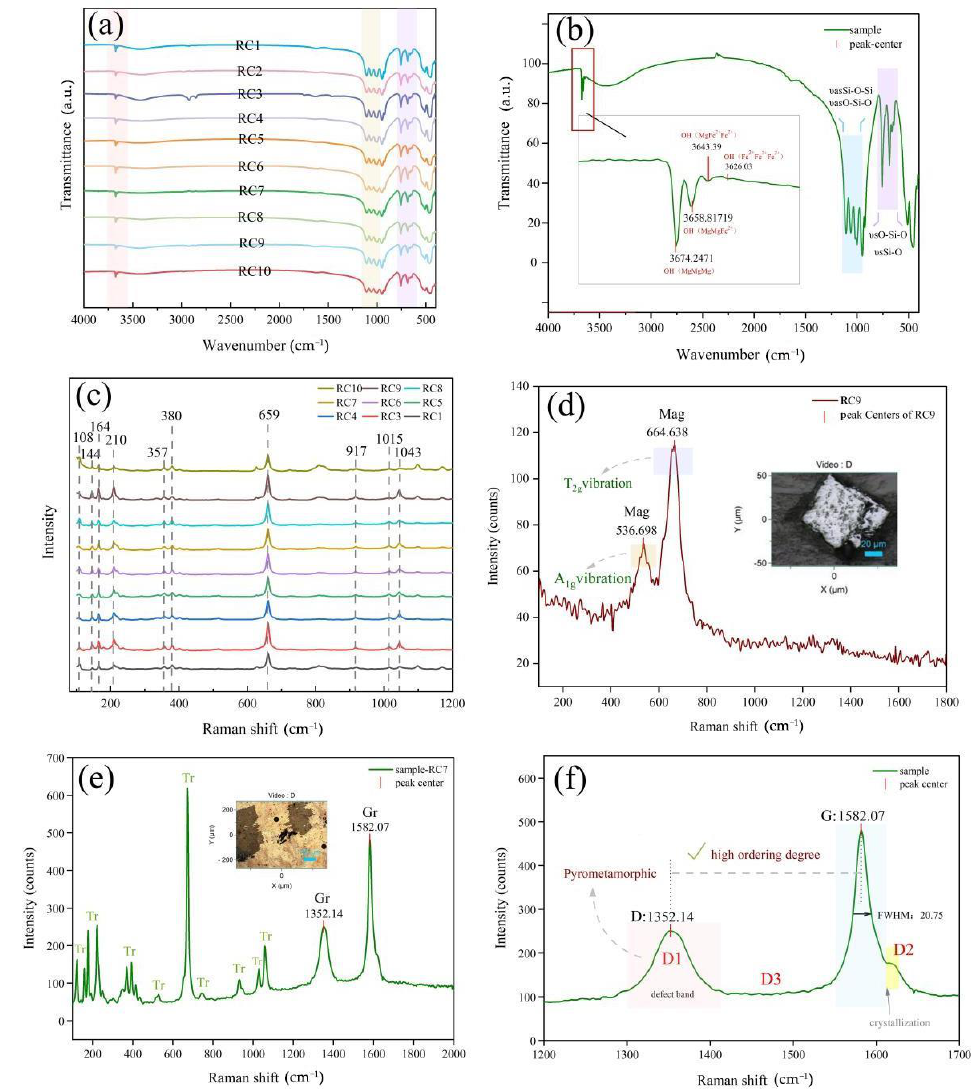
Figure 7. ( a , b ) Infrared transmission spectra of tremolite. ( c ) Raman spectra of tremolite. ( d ) Raman spectrum of magnetite. ( e ) Raman spectrum of graphite. ( f ) Enlarged view of a characteristic peak in Figure 7e. Mag: magnetite; Gr: graphite.